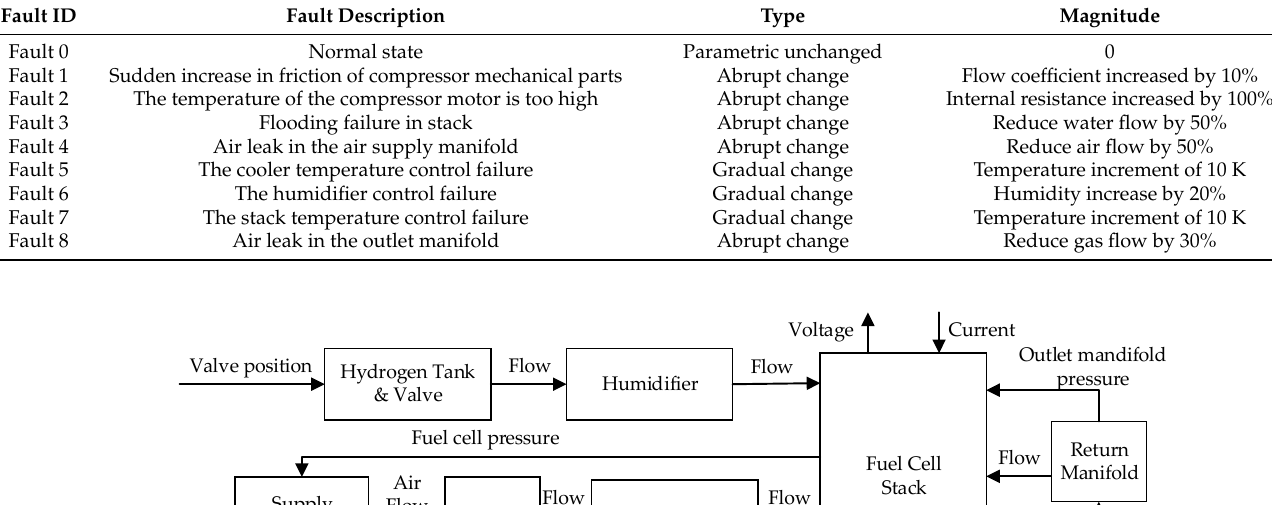
Table 2. Faults in the PEM fuel cell simulator model. Developed from [26].